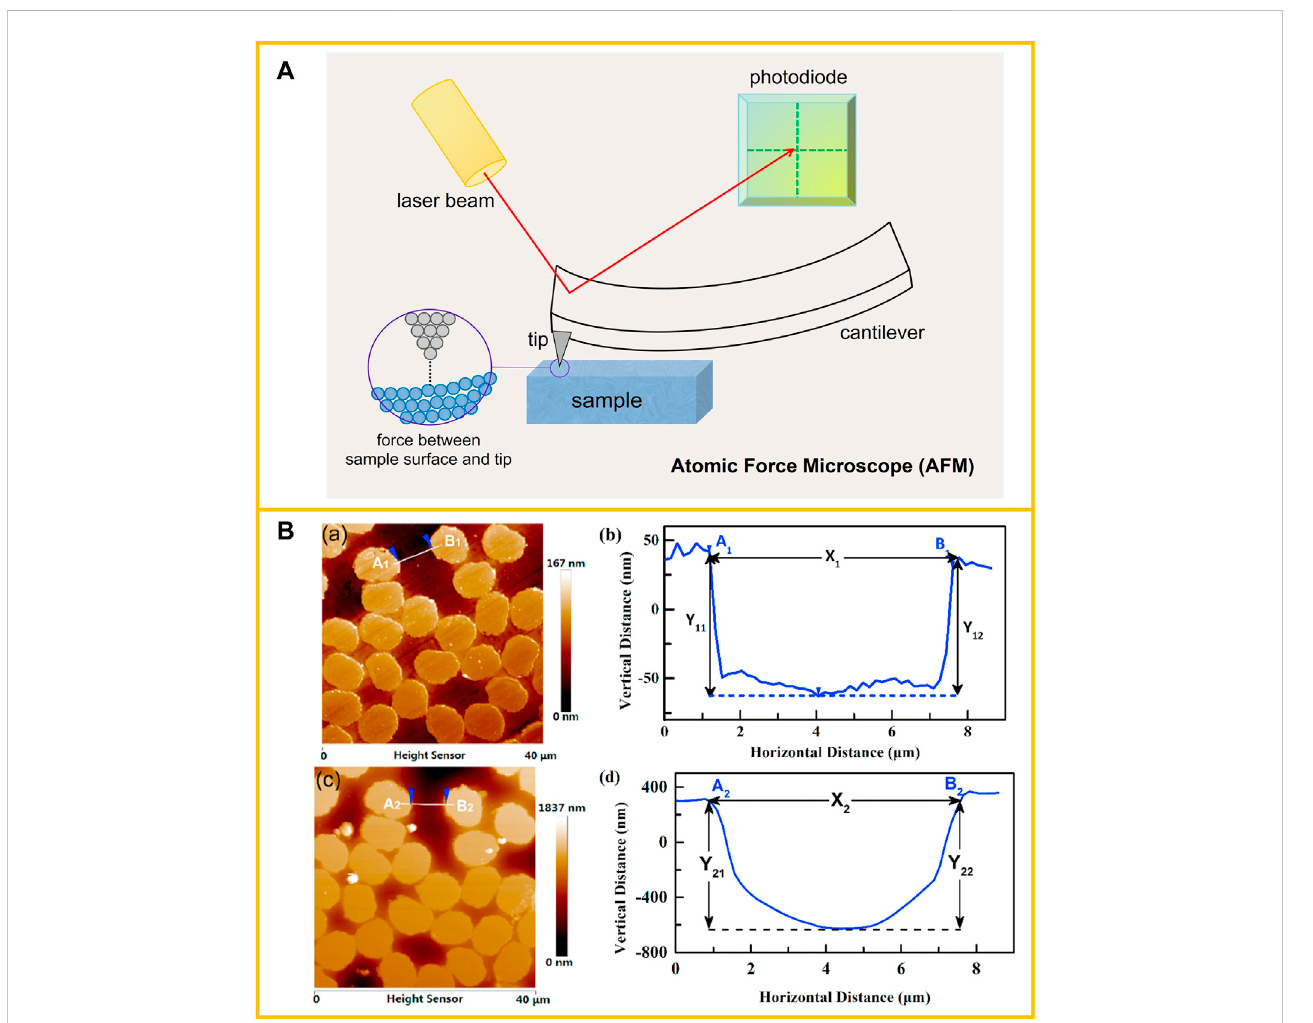
FIGURE 4 (A) Illustration ofan AFM operatingprinciple. (B) TheAFM topography and height linepro fi les ofacross-sectional composite.(a)AFM topography before treatment;(b)heightlinepro fi